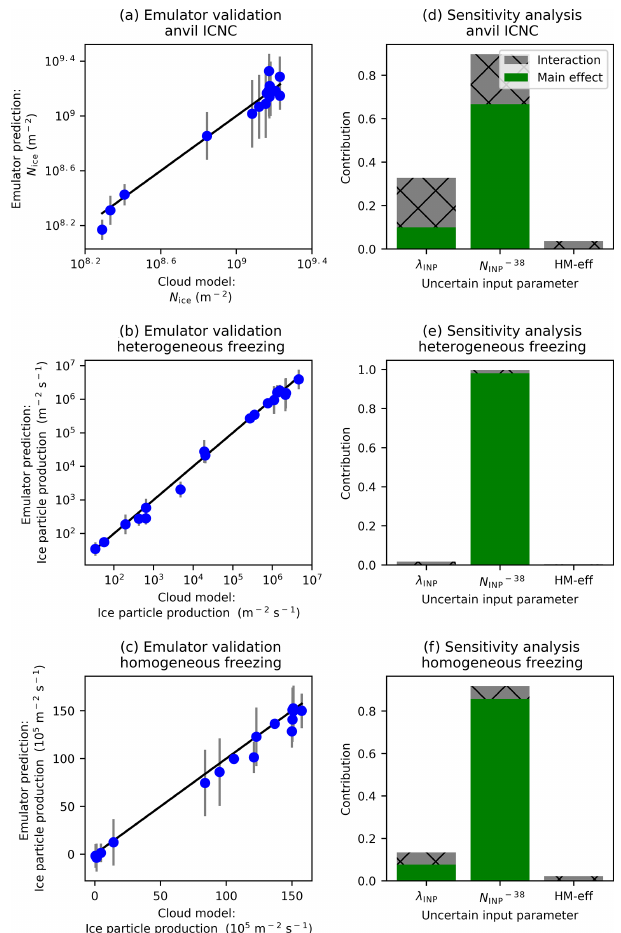
Figure 7. Emulator validation and uncertain input contributions to output uncertainty. Validation of emulator results (a–c) and results of the variance-based sensitivity analysis (d–f) for anvil ICNC (a, b) , ice particle production by heterogeneous freez- ing (c, d) , and ice particle production by homogeneous freez- ing (e, f) . In panels (a) – (c) , the dots show the value of the validation run on the x axis and the corresponding emulator mean prediction on the y axis. The 95% confidence intervals on the emulator predic- tions are also shown. An emulator that validates well will have dots close to the 1 : 1 line and small error bars. Panels (a) and (d) are the average of the cloud property between 150 and 240min (anvil stage) of the simulation, while panels (b) , (c) , (e) , and (f) are the average of the relevant cloud property between 60 and 180min (convective stage) of the